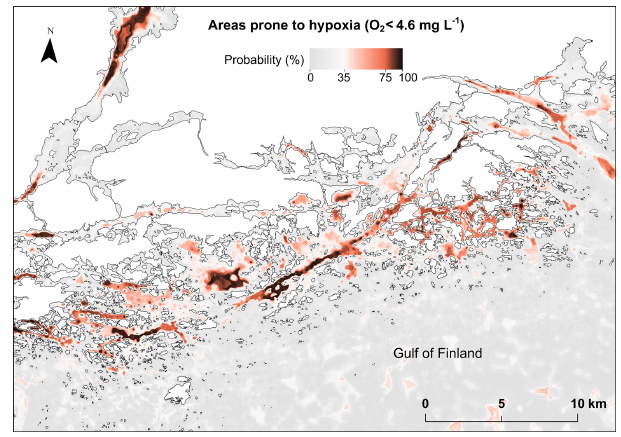
Figure 7. Modeled probability (%) of detecting frequent hypoxia O 2 (<4.6mgL − 1 ) due to topography in an example area off the southern coast of Finland. Land shown as white